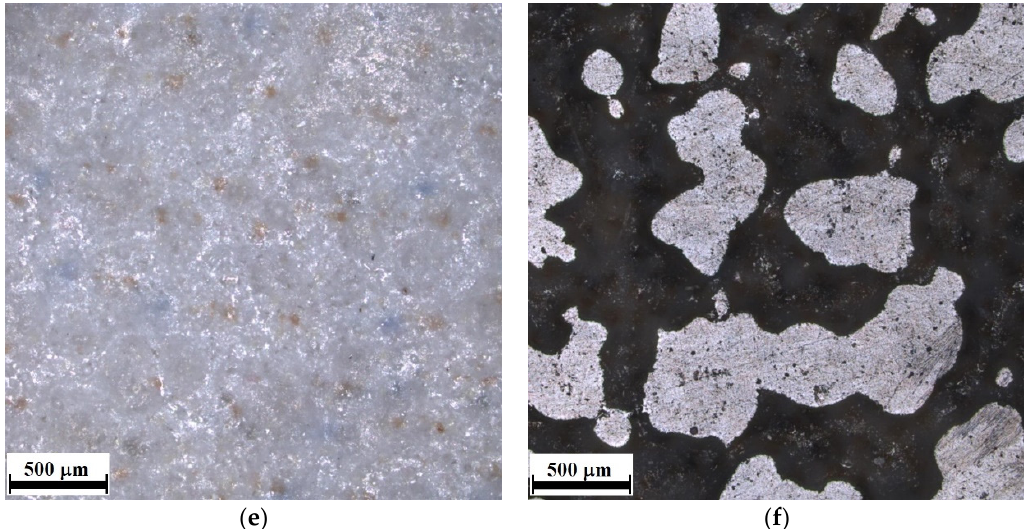
Figure 1. Optical microscopy (OM) photos of ceramic tile outer structure: ( a ) S1, ( b ) S2, ( c ) S3, ( d ) S4, ( e ) S5, and ( f ) S6 sample.